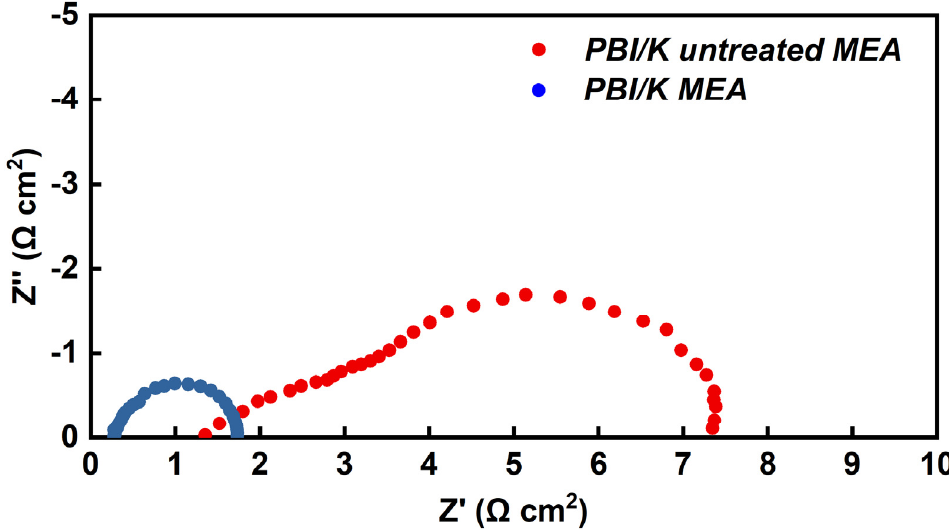
Figure 8. Nyquist plots of treated and untreated PBI/K MEAs at 20 mA cm − 2 of output DC density at 160 °C, feeding with dry H 2 /O 2 (equal H 2 and O 2 flow rates at 0.4 L min − 1 ).